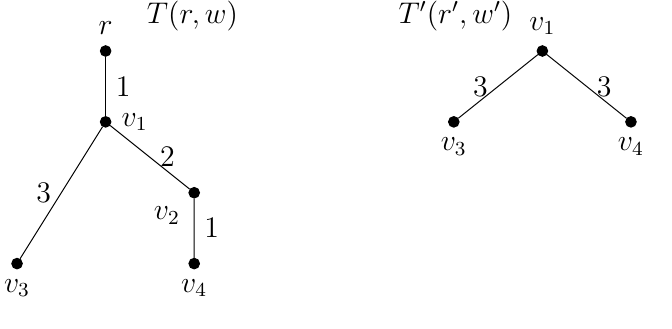
Figure 11: Here T ( r, w ) and T (cid:48) ( r (cid:48) , w (cid:48) ) are equidistant, r (cid:48) = v holds for every { u, v } ∈ E ( T (cid:48)